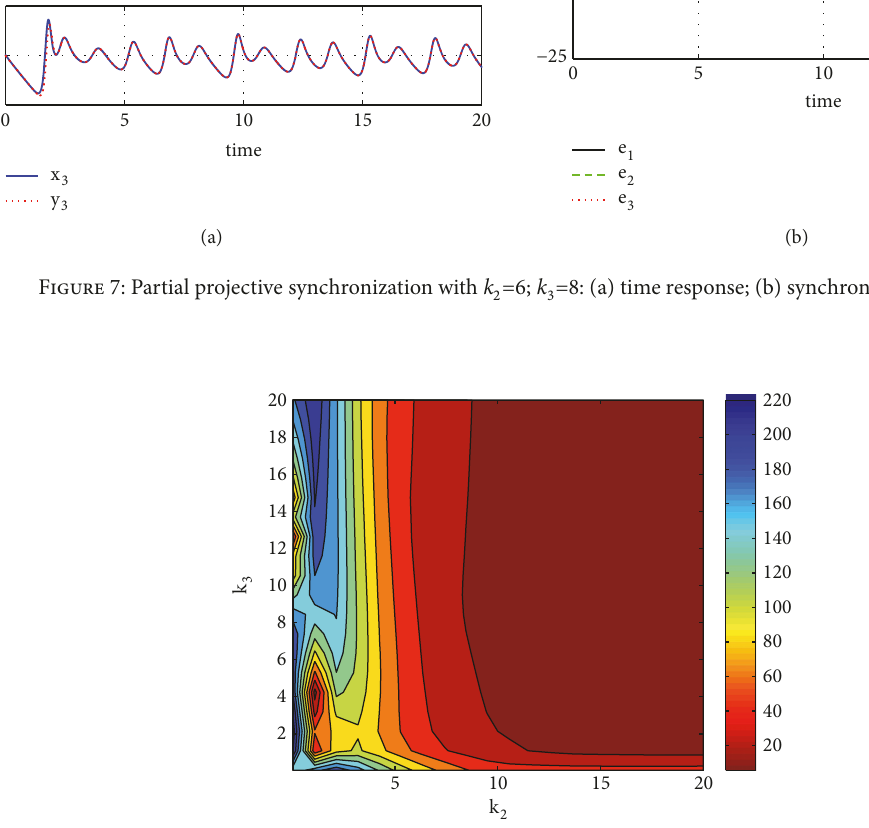
Figure 8: The distribution of the maximal power consumption of synchronous